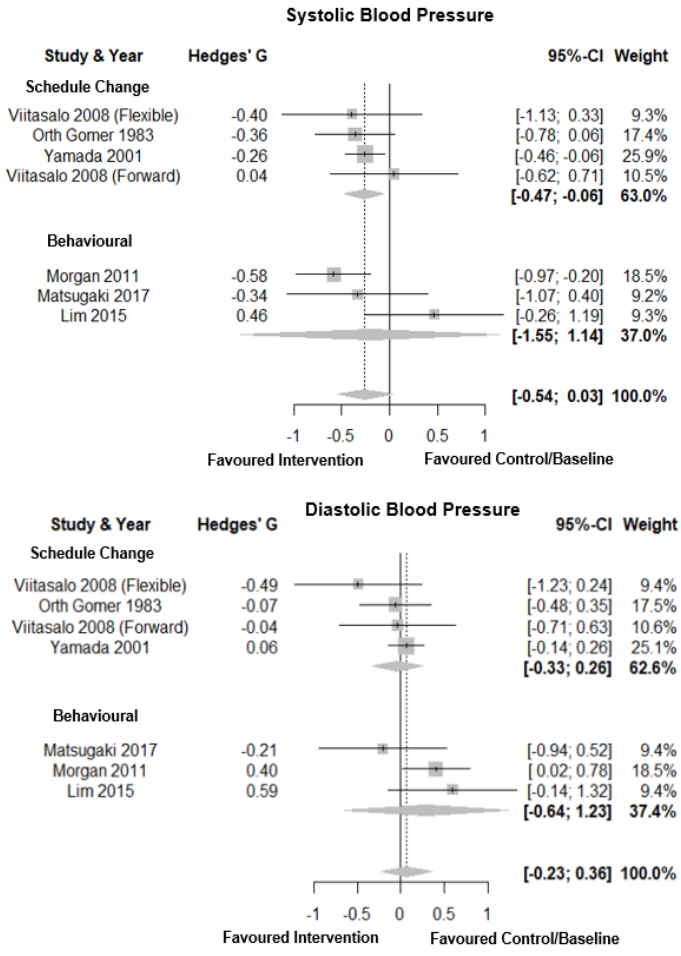
Figure 2. Forest plot for intervention by type on systolic and diastolic blood pressure. Note. Inter- ventions with multiple conditions are denoted within brackets.